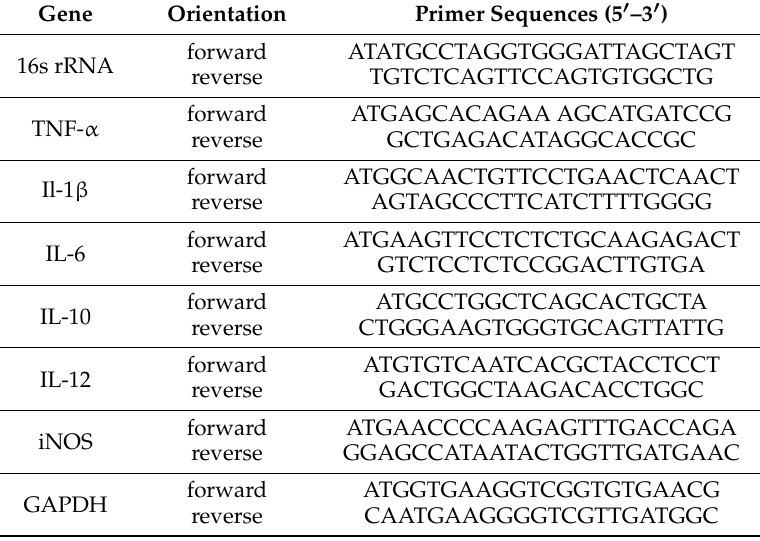
Table 2. Primer sequences and fragment sizes of the targeted genes in real-time PCR. Gene